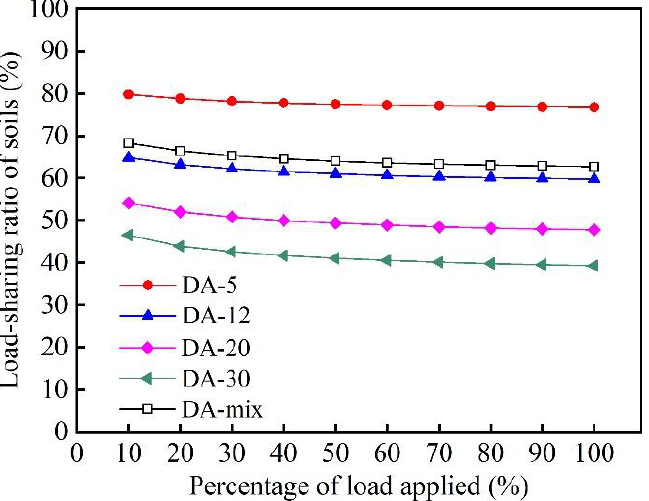
Figure 14. Curve of load-sharing ratio of soils variation with percentage of load applied.